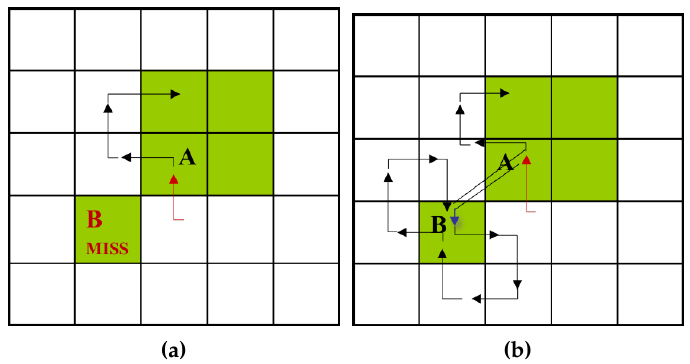
Figure 3. Detour of the inner-outer corner at the left-rear pixel (modified version of [3]). ( a ) Simple boundary follower (SBF); ( b ) modified SBF (MSBF).